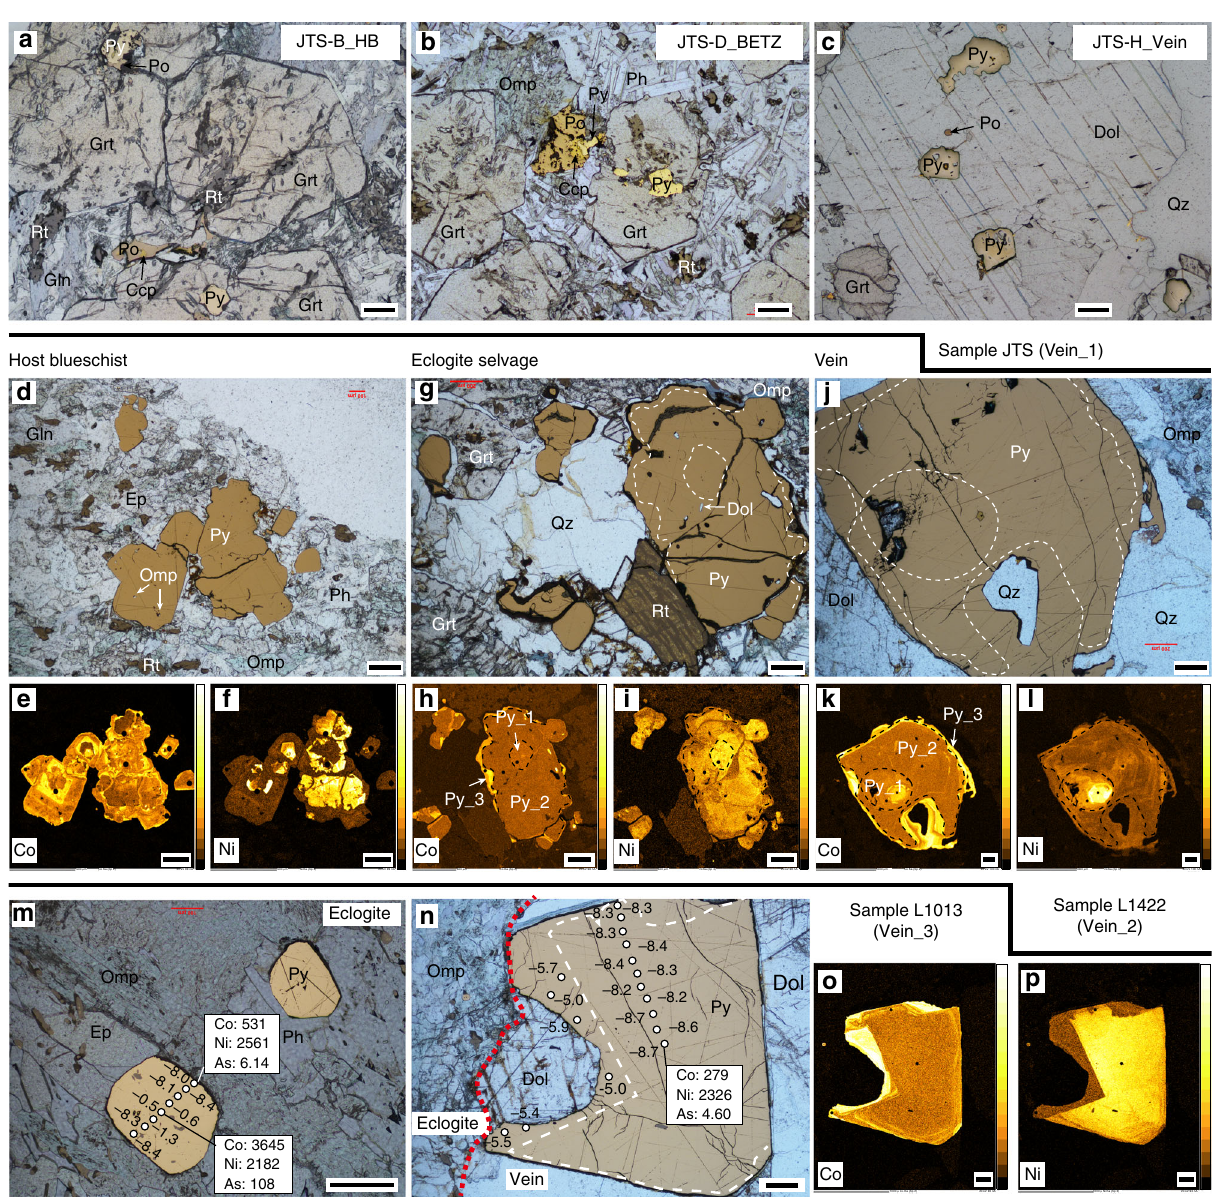
Fig. 2 Photomicrographs and element mapping of sul fi des. a – c Sul fi des in sample JTS. Sul fi des in garnet are mainly pyrite with minor pyrrhotite and chalcopyrite, whereas the matrix contains mainly pyrrhotite with minor chalcopyrite and pyrite in both the host blueschist ( a ) and blueschist – eclogite transition zone ( b ). d – i Photomicrographs and Co – Ni maps of pyrite in the host blueschist ( d – f ), eclogite selvage ( g – i ), and vein ( j – l ) in sample L1422. m – p Pyrite, δ 34 S values, and Co – Ni maps in sample L1013. Trace-element concentrations ( µ g g − 1 ) of pyrite are given in the white rectangles. δ 34 S values and Co – Ni maps in vein pyrite ( n – p ) suggest two growth generations. All photomicrographs (except Co – Ni maps) use superposed transmitted and re fl ected light to simultaneously image silicates and sul fi des. Mineral abbreviations: chalcopyrite (Ccp), dolomite (Dol), epidote (Ep), garnet (Grt), glaucophane (Gln), omphacite (Omp), phengite (Ph), pyrite (Py), pyrrhotite (Po), quartz (Qz), and rutile (Rt). Scale bar: 200 μ